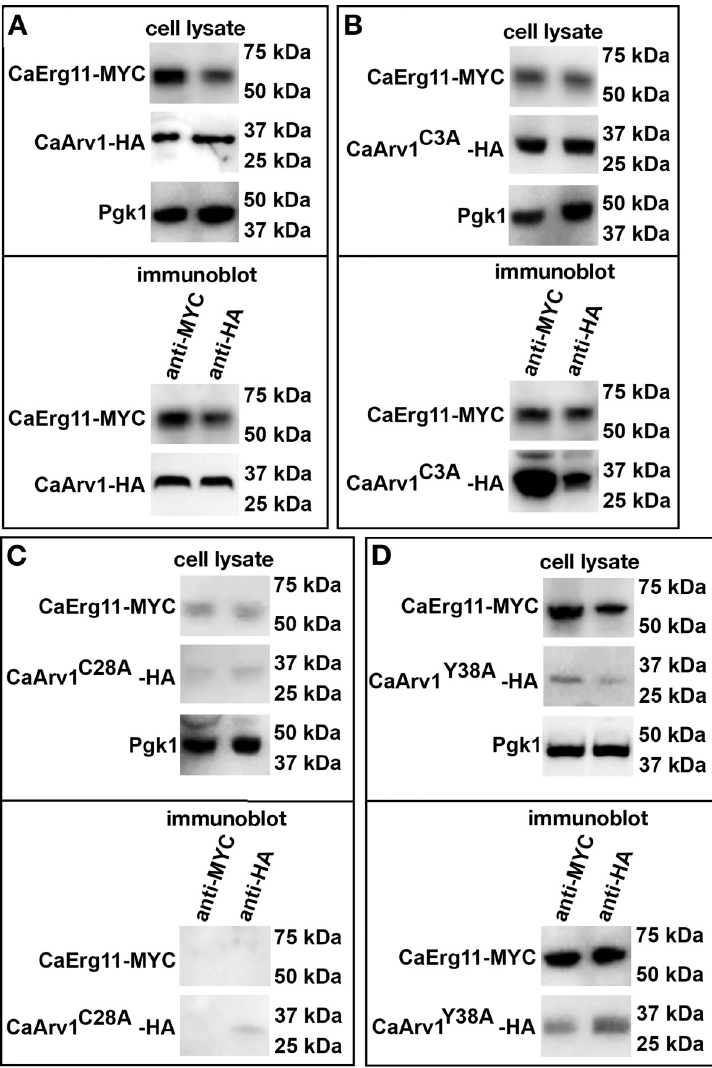
Fig 8. CaArv1 C28A is unable to co-immunoprecipitate with ScErg11. Scarv1 cells co-expressing mutant CaArv1-HA and wild type CaErg11-MYC were grown to exponential phase in the appropriate plasmid selection medium. (A-D), represent the co-immunoprecipitation western results of Scarv1 cells co-expressing CaArv1 mutants and CaErg11-MYC (immunoblot). The cell lysate panels represent Erg11-MYC or Arv1-HA protein levels in total cell lysates. The differences in the detection observed for certain Arv1 mutants and Erg11 may be due to the use of protein lysates from steady state cells, and is strain dependent. The panels represent data from 3 individual